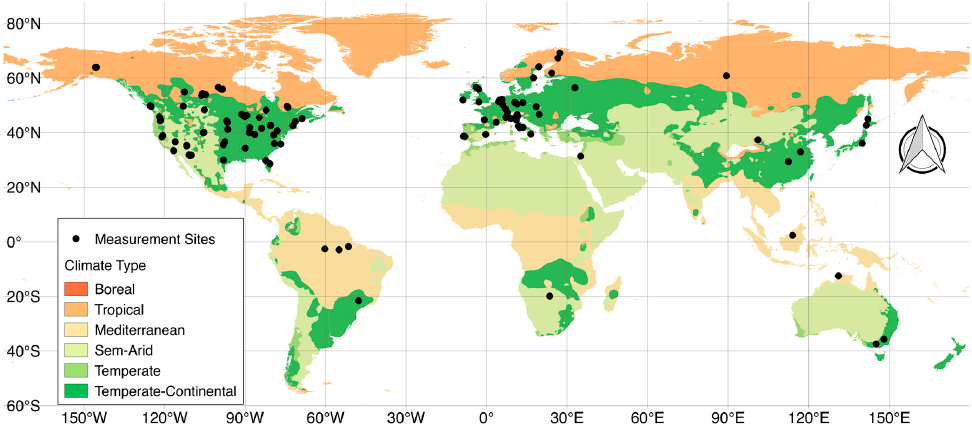
Figure 1. Location of the FLUXNET and Surface Radiation budget network (SURFRAD) sites used in this study.